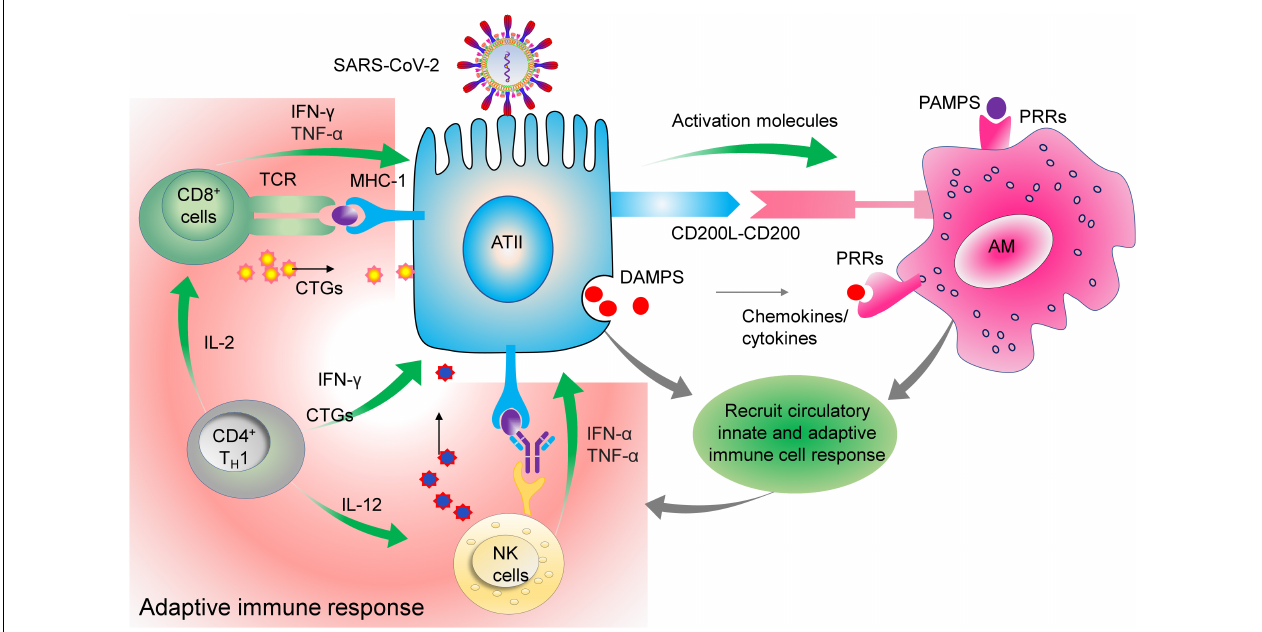
FIGURE 3 | Clearance of virus infected cells by engaging adaptive immune cells. Virus infected ATII cells activate the neighboring lung resident AMs by minimizing the CD200-200L interaction. Additional requisite activation signals are provided by DAMPs, viral derived PAMPs, and cytokines like IFN- γ . Activated AMs along with infected ATII derived molecules activate and recruit other innate immune cells, like circulating monocytes, dendritic cells, NK cells, and neutrophils which act in a coordinated manner to eventually recruit the adaptive effector immune cells like CTLs and CD4 + T cells. These adaptive immune cells then specifically eliminate virus infected cells while minimizing the damage to the nearby uninfected cells. Thus, a well-coordinated and regulated adaptive immune response with help from innate immune cells is critical for initial antiviral response to limit the further spread of the virus. Green arrows indicate the cytokines released by the respective activated immune cells which activate other immune cells as well as mount an antiviral response by acting on lung epithelial